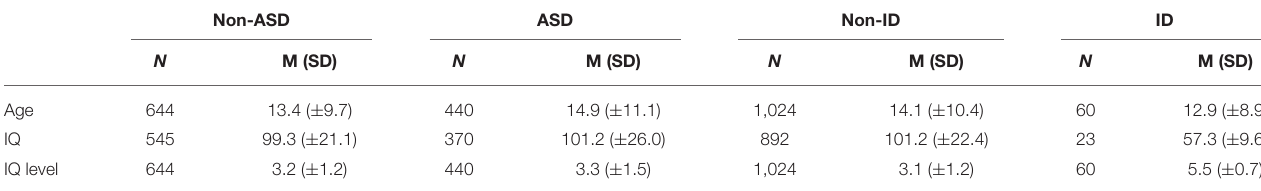
TABLE 1 | Sample characteristics.